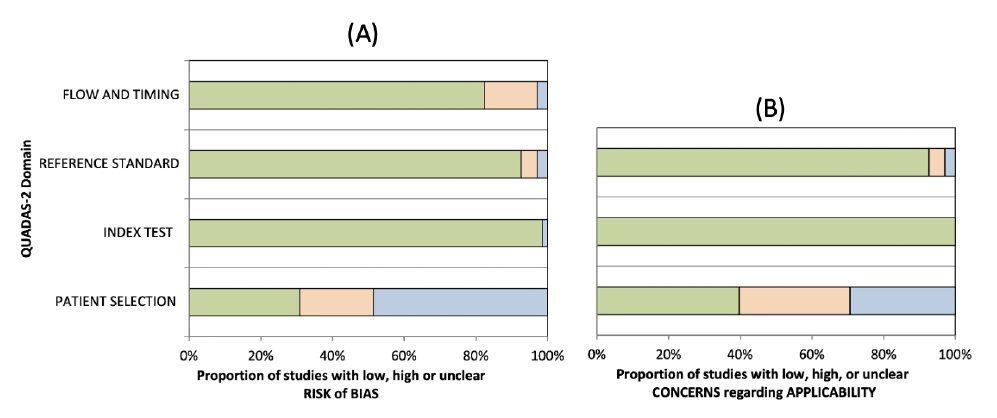
Figure 2. Summary of the methodological quality of included studies regarding the 4 domains assessing the risk of bias ( A ) and the 3 domains assessing applicability concerns ( B ) of the QUADAS- 2 score. The portion of studies with a low risk of bias are highlighted in green, studies with an unclear risk of bias are depicted in blue and studies with a high risk of bias are represented in